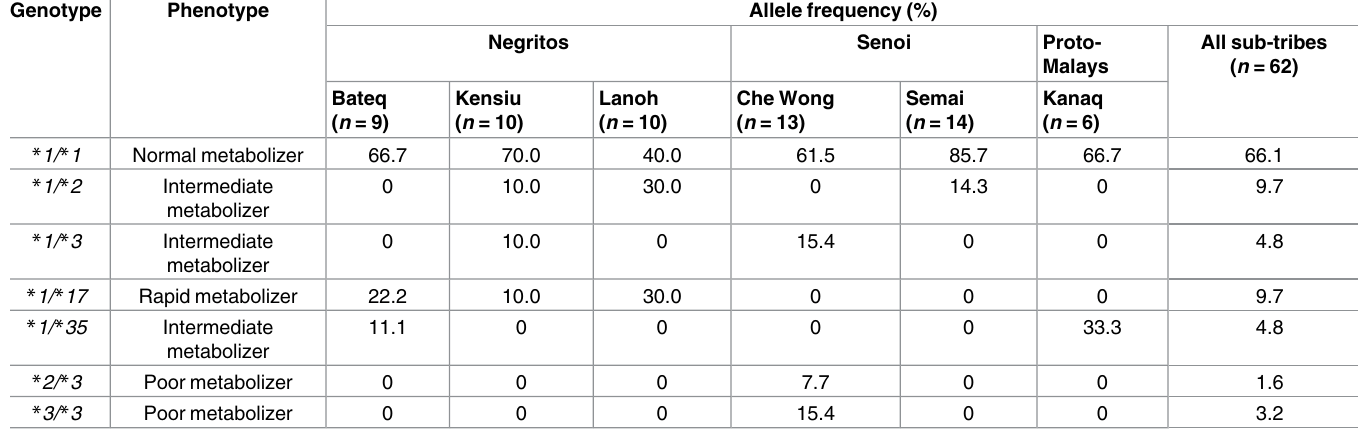
Table 3. CYP2C19 genotype frequencies in the Orang